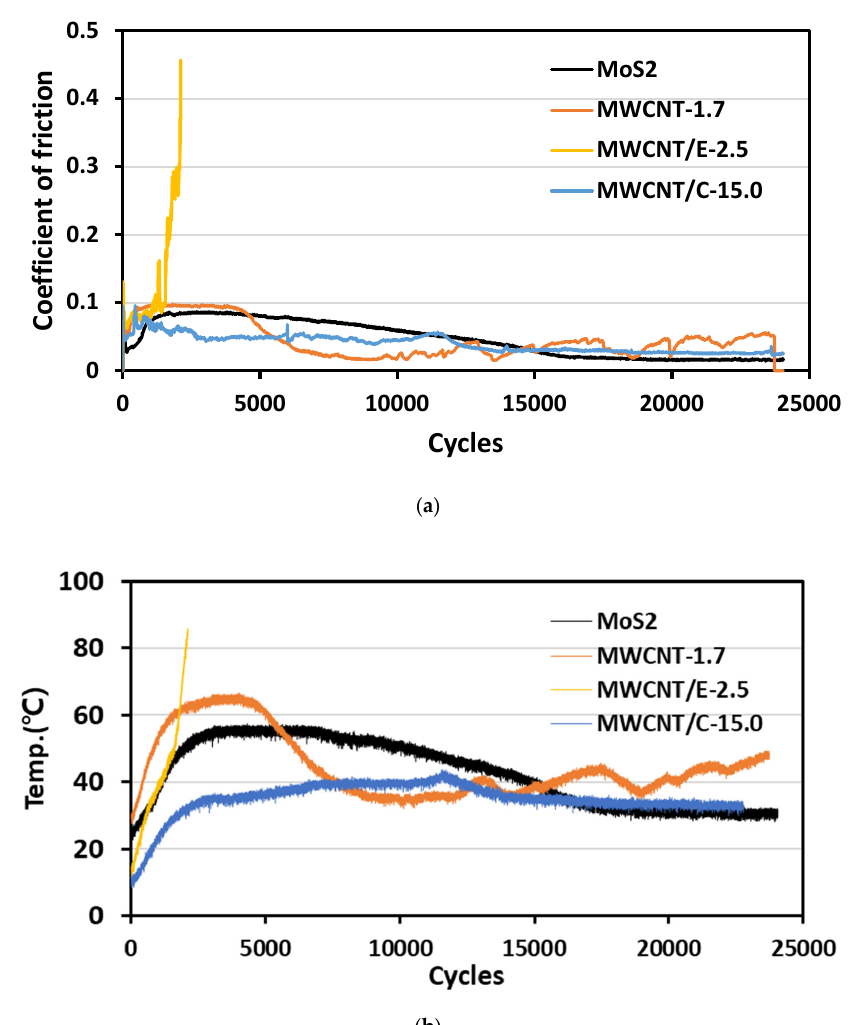
Figure 4. Evaluation of ( a ) the CoF of the bush and shaft when MoS 2 and MWCNT are added to the solid lubricant and ( b ) the surface temperature by friction caused by external load flow. Of the MWCNT-based samples, MWCNT-1.7 had an initial CoF of 0.1. It became worn after 5000 cycles, but the CoF remained low owing to its low hardness. MWCNTs